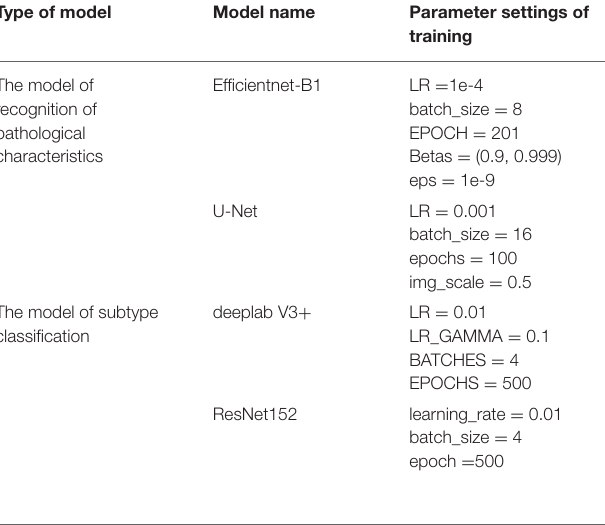
TABLE 4 | The different model parameter settings of training.